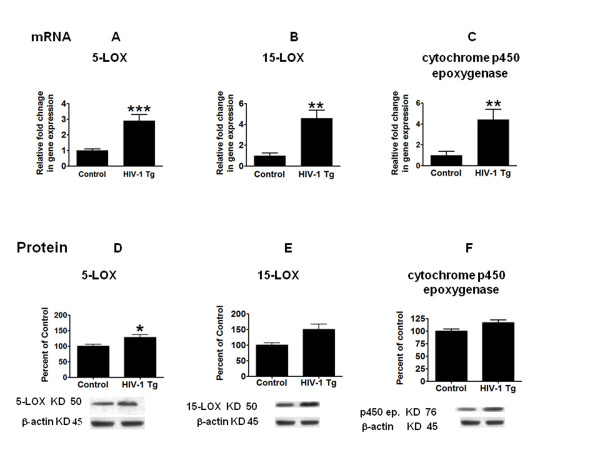
mRNA levels of brain 5-LOX BB(A), 15-LOX (B) and cytochrome p450 epoxygenase (C) in control and HIV-1 Tg rats, measured using real time TaqMan RT-PCR. Data represent individual transcript levels normalized to β-globulin, in HIV-1 Tg rat brain relative to control level (calibrator) using the ΔΔCT method. Representative immunoblots of (D) 5-LOX, (E) 15-LOX, and (F) cytochrome p450 epoxygenase protein in control and HIV-1 Tg rats. Bar graphs display ratios of optical densities of individual protein bands to β-actin, expressed as percent of control. Mean ± SEM, statistical significance: **p < 0.01, ***p < 0.001 as determined by an unpaired t-test.